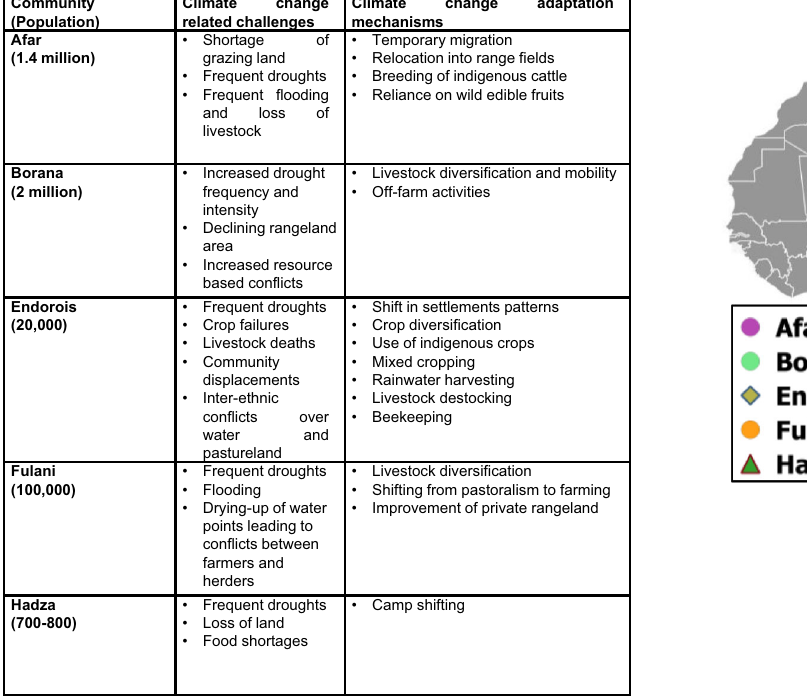
Fig. 1 Spatial distribution of different African communities, climate-change-related challenges faced, and adaptation mechanisms being